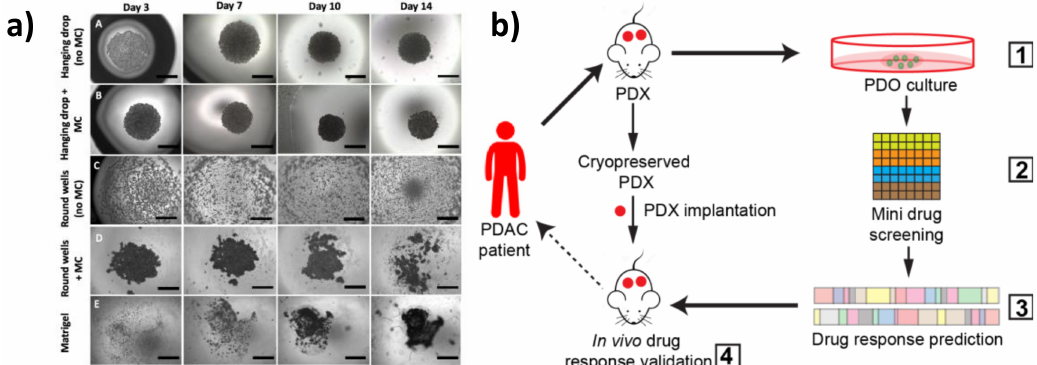
Figure 1. Three-dimensional (3D) in vitro models of pancreatic cancer. ( a ) MiaPaCa-2 spheroid growth using different methods. Scale bars = 1000 µ m (adapted from [21]). ( b ) Schematic representation of the patient-derived organoid (PDO)- derived system. (1) Generation of PDO and patient-derived xenograft (PDX) models from cryopreserved xenografts of patients with pancreatic ductal adenocarcinoma (PDAC). Screening of Food and Drug Administration (FDA)-approved drugs (2) and validation in organoid cultures (3). Selection of effective drugs for small-scale drug screenings and validation in the PDXs (4) (adapted from